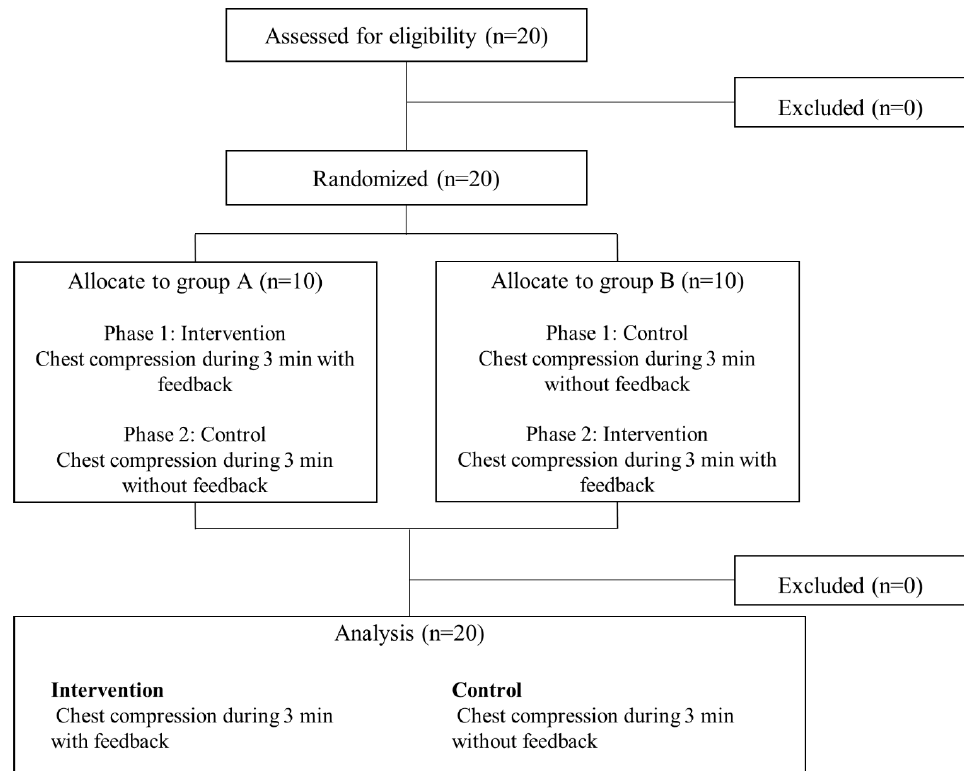
Figure 2. A flowchart of participant enrollment process.